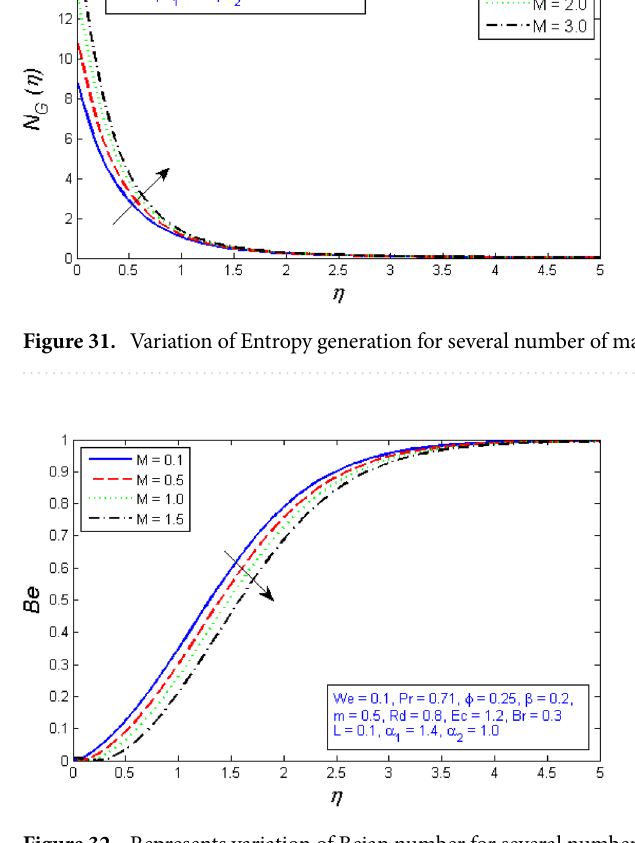
Figure 32. Represents variation of Bejan number for several number of magnetic parameter M .